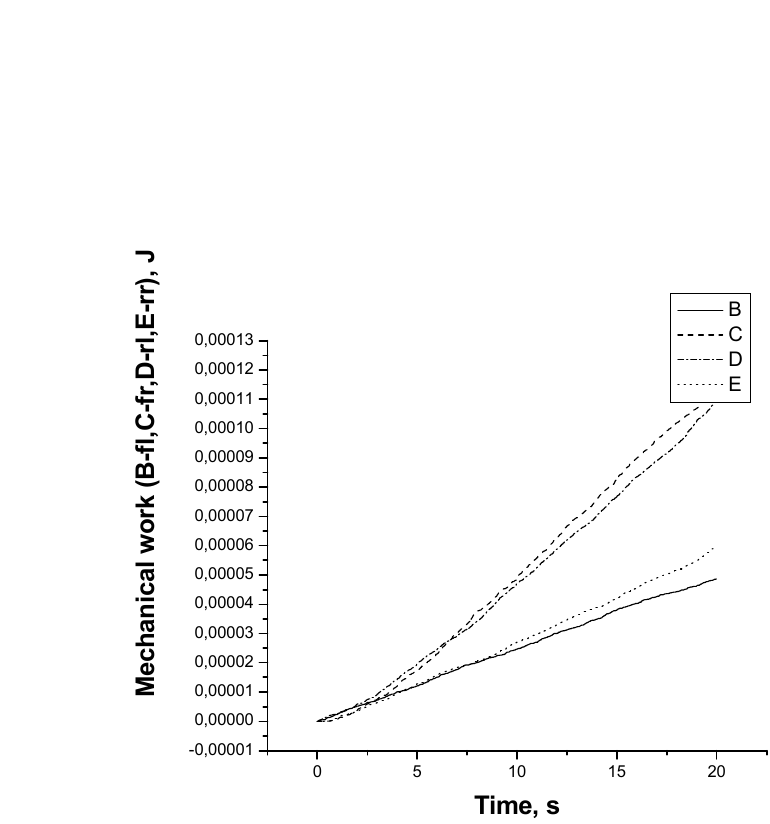
Time, s Figure 2 – Mechanical work (heat amount) of the shock absorbers in a partially loaded vehicle at a speed of 5,